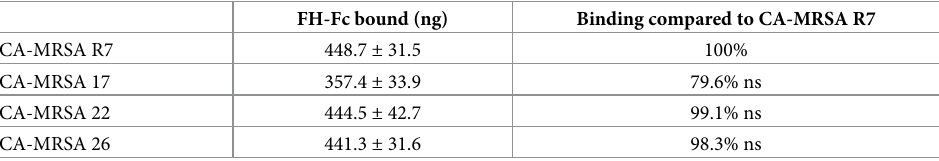
Table 4. FH-Fc binding to various CA-MRSA isolates.